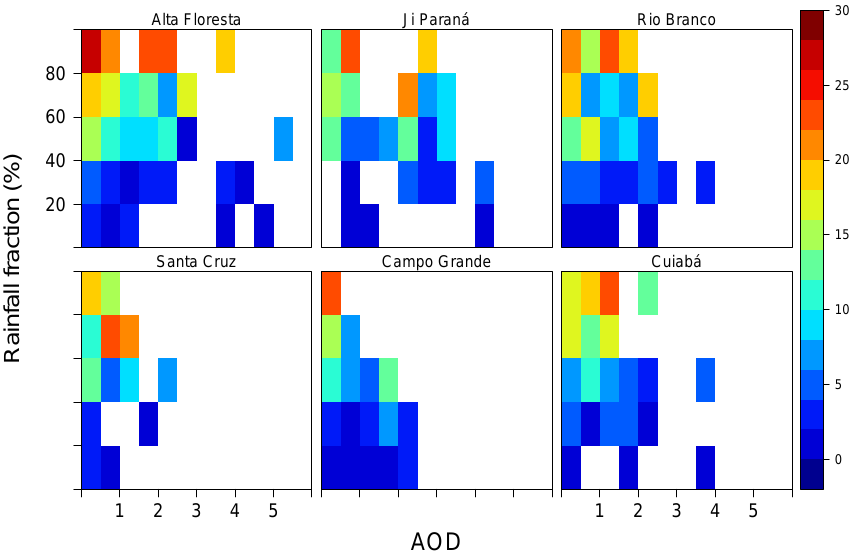
Fig. 8. Two-dimensional histogram of the average rainfall rate for each AERONET station for all selected cases (see Sect. 2.4) during the months of September, October, November and December of 1999–2012. Colors indicate average rainfall rate for each bin of rainfall fraction and AOD.